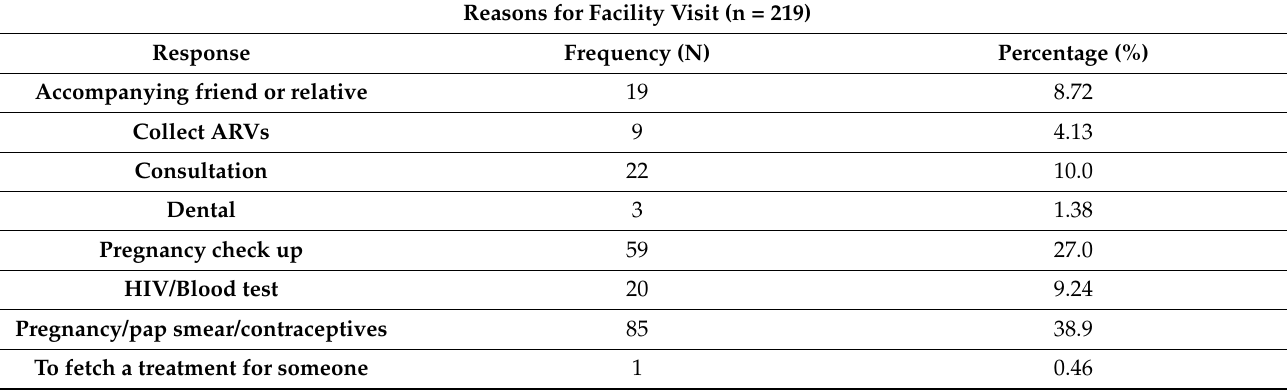
Table 11. Participants’ reasons for facility